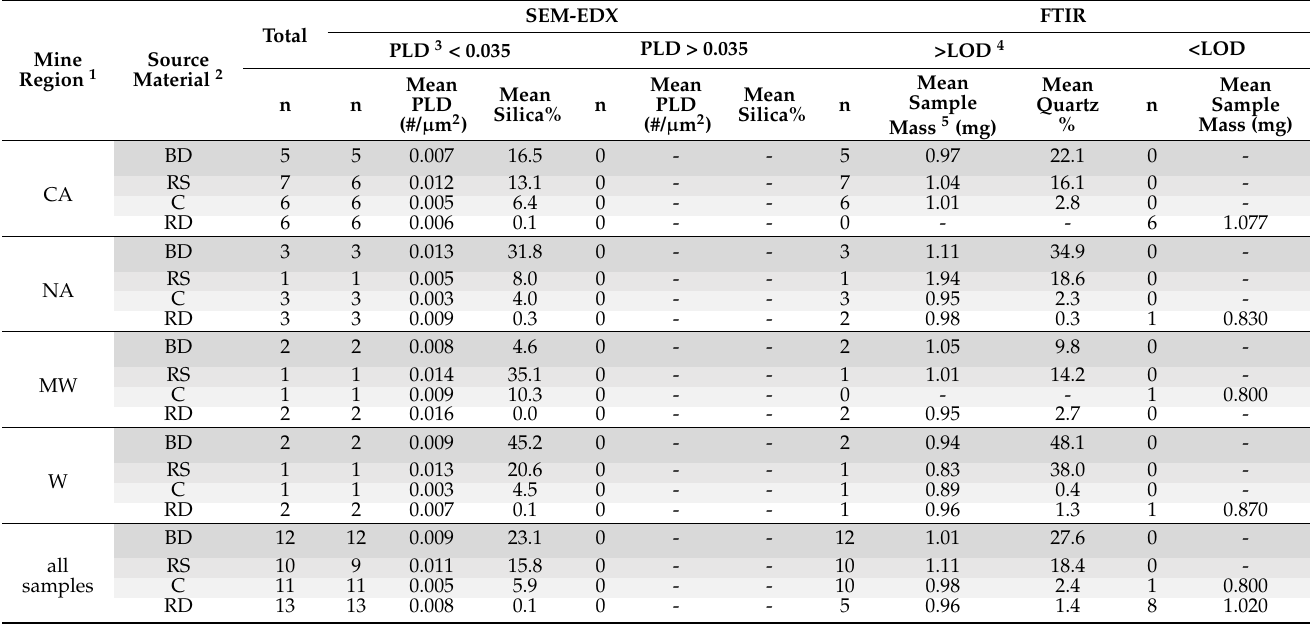
1 Region: CA = central Appalachia; NA = northern Appalachia; MW = mid-west; W = west. 2 Material type: BD = bolter dust; RS = run-of-mine (ROM) rock strata; RD = rock dust; C= ROM coal. 3 PLD: Particle loading density = number of particles/analyzed area (#/ µ m 2 ). 4 LOD: limit of detection for quartz mass = 3.74 µ g (= 0.026/0.00695, Integrated peak area/calibration factor for lab generated samples in two-piece cassette). 5 mean sample mass (mg) = averaged dust mass on PVC